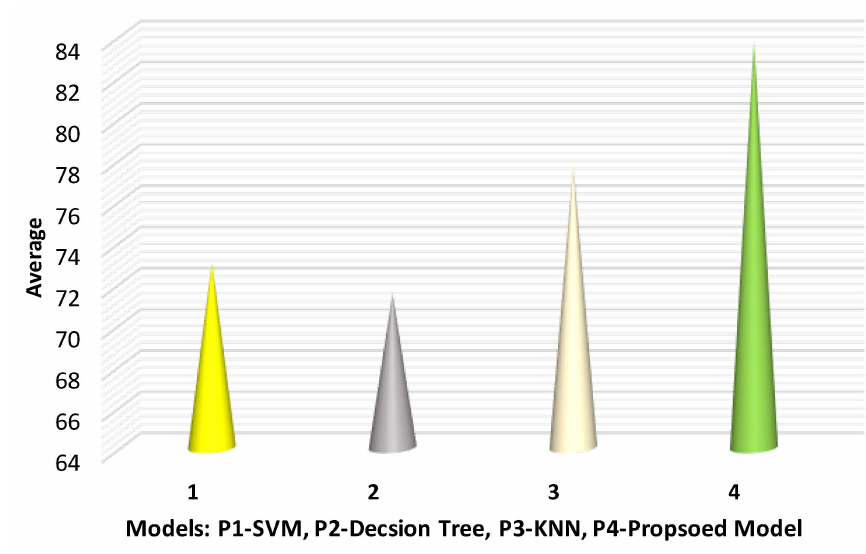
Figure 6. Average accuracy analysis with different models.